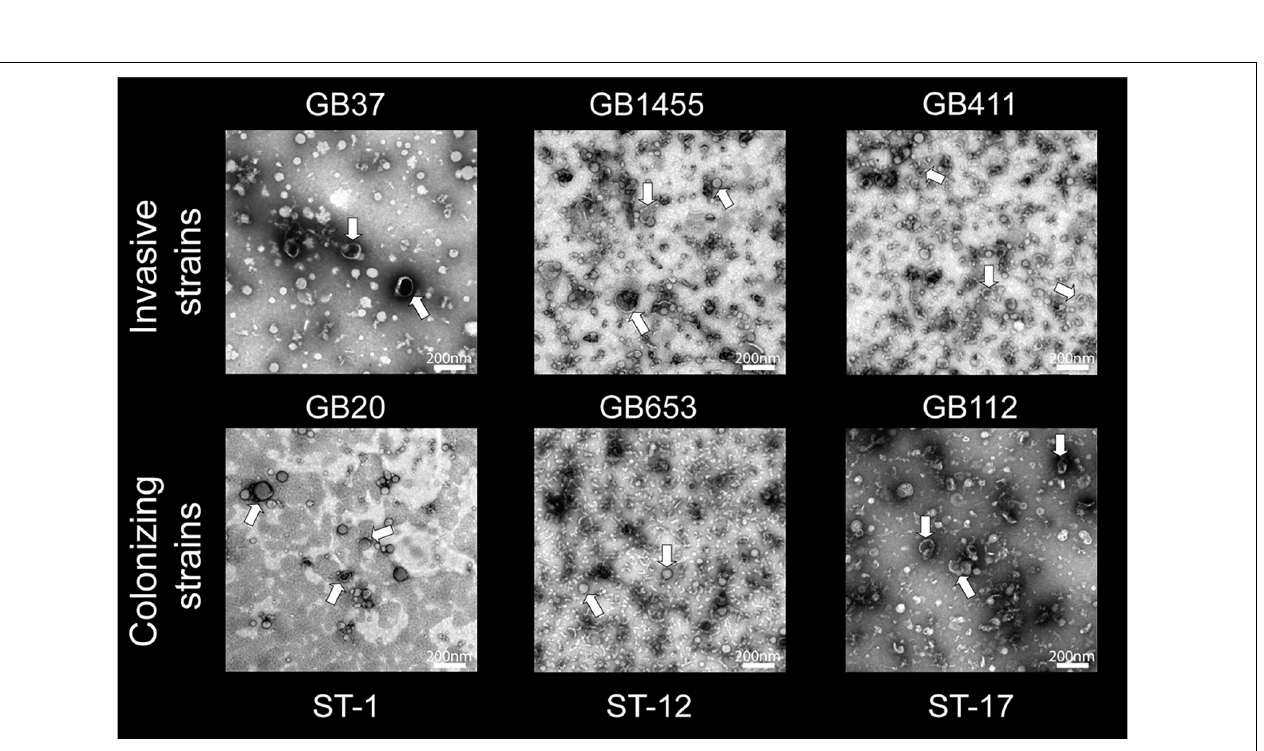
FIGURE 2 | Transmission electron microscopy (TEM) of membrane vesicles (MVs) isolated from the six group B streptococcal strains. An abundance of spherical structures with a bright membrane bilayer and slightly electron dense interior was observed ranging in size between ∼ 50 and 100 nm. The MV population was isolated from each strain following late logarithmic growth. MVs were purified using ultracentrifugation and size exclusion chromatography (2–3 replicates per strain). TEM images were taken at a magnification of 20,000 × ; the scale bars indicate a length of 200 nm.